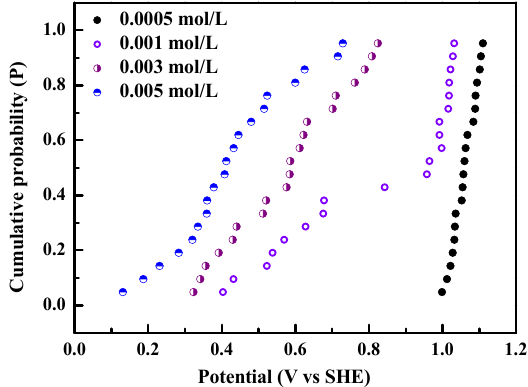
Figure 8. Cumulative probability distribution of the pitting potential of steel bar under different chloride concentration at pH 11.5.